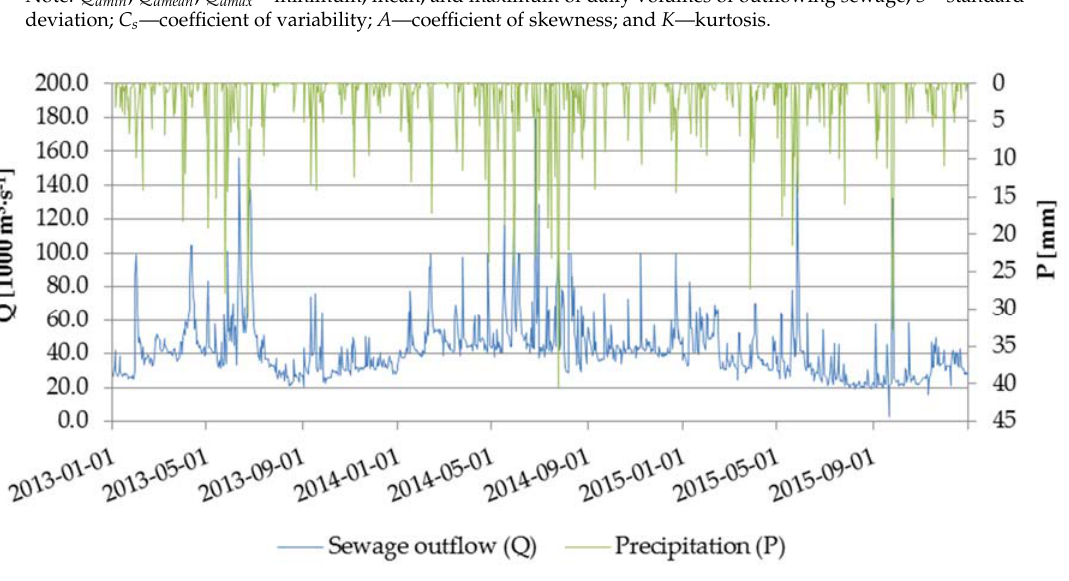
Figure 2. The volume of the daily sewage outflow from the urban agglomeration of Radom against the background of the daily atmospheric precipitation in the years 2013–2015.